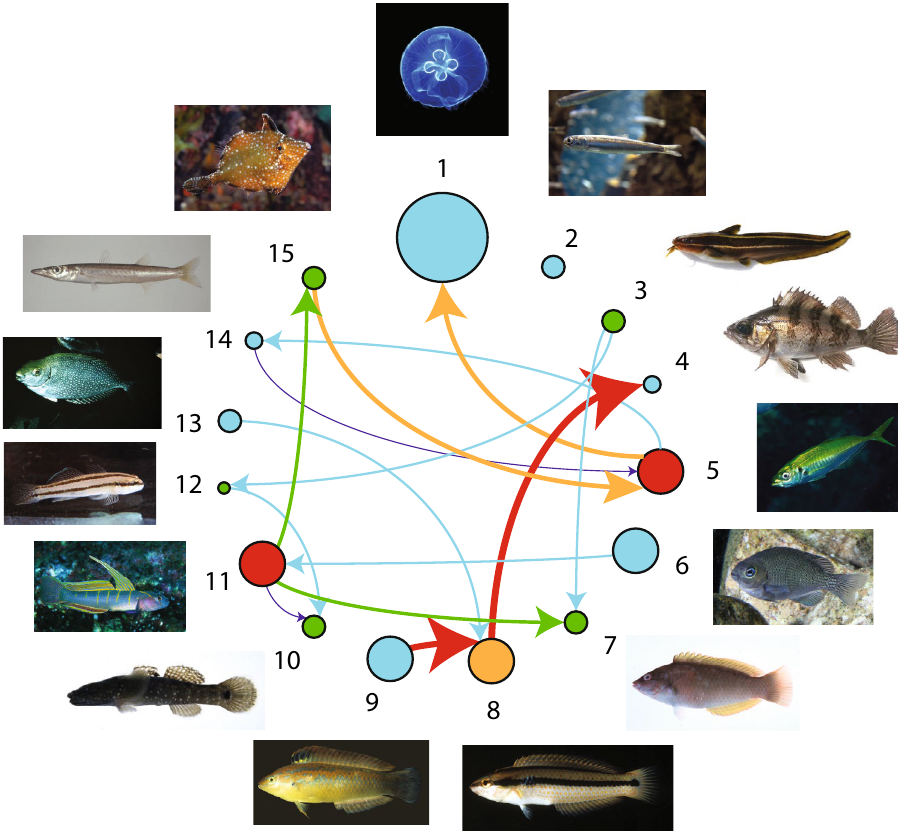
Figure 6. Part of the estimated species interaction network for the Maizuru Bay ecosystem. Species properties are reported in Table S1. The color and width of links are proportional to the magnitude of TE (Table S2); for the former a red-blue scale is adopted where the red/blue is for the highest/lowest TEs. The diameter is proportional to the Shannon entropy of the species abundance (Table S3) that is directly proportional to the degree of uniformity of the abundance pdf and the diversity of abundance values (e.g., the higher the zero abundance instances the lower the entropy). The color of nodes is proportional to the structural node degree, i.e. how many species are interconnected to others after considering only the CCM derived largest interactions (see Ushio et al. 37 and Fig. 7). Other interactions exist between species as reported in Fig. 7. TE is on average proportional to ρ (Figs. S4 and S5). Freely available fish images are from FishBase https:// www. fishb ase. in/ search. php; the network was created in Matlab and the composition of network and images was made in Adobe Illustrator version 21 (2017) https:// www. adobe. com/ produ cts/ illus trator.